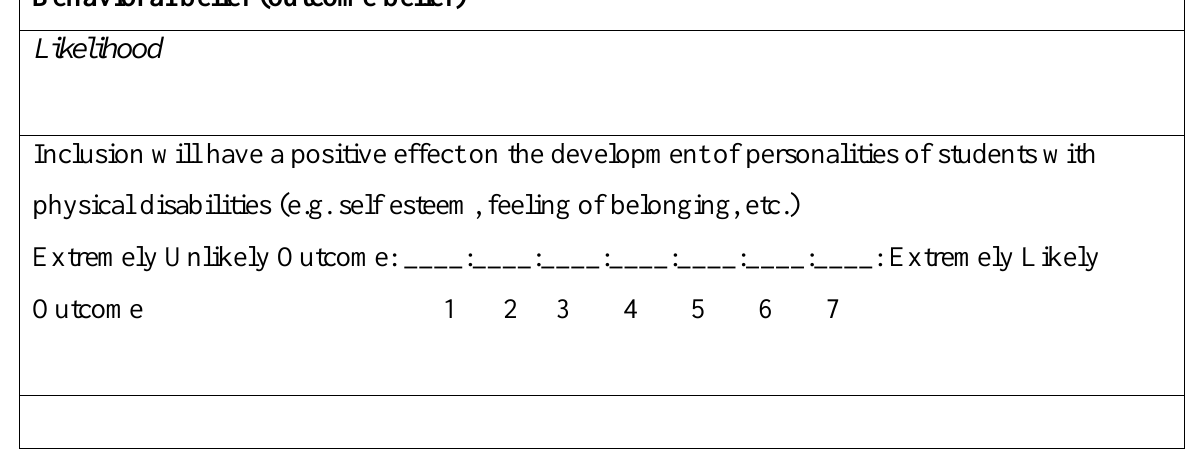
Table 2 Sample items from the attitudinal scale Behavioral belief (outcome belief)